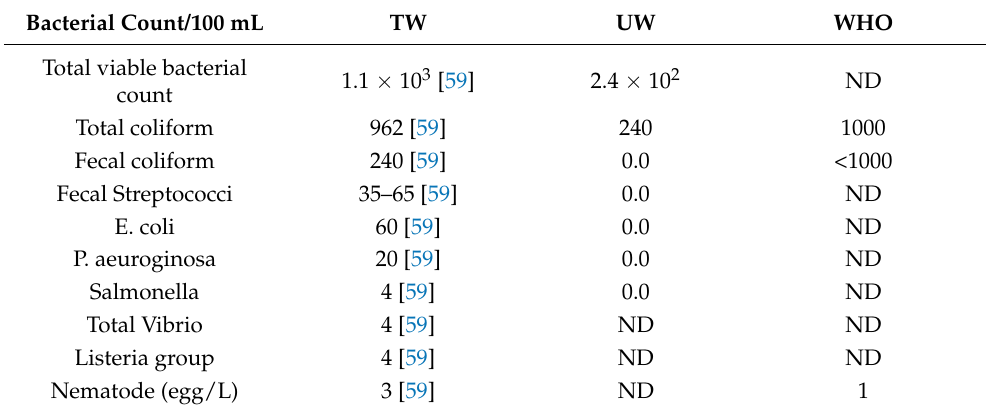
Table 4. The bacteria present in the treated water and in the underground water (data from [59]). Bacterial Count/100 mL Total viable